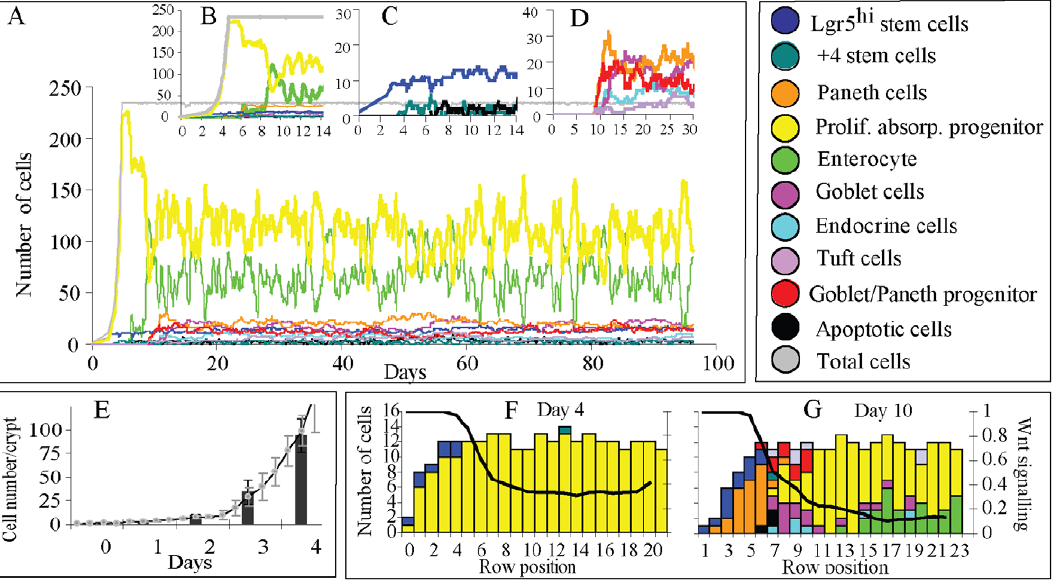
Figure 3. Modelling crypt development from a single stem cell. A–D) The number of cells during the development of a crypt from a single stem cell. The total number of cells, 235, is reached in about 5 days with a structural steady state reached by day 11. The simulation is for 100 days. E) Comparison between simulated (circles) and observed (columns) numbers of cells in a crypt developing from one stem cell [6]. Data shown is from 30 simulated crypts. F) Cellular crypt composition and Wnt signalling by day 4 when the growing crypt reaches its final number of cells. G) Cellular crypt composition and Wnt signalling by day 10 when the crypt reaches a structural steady state.